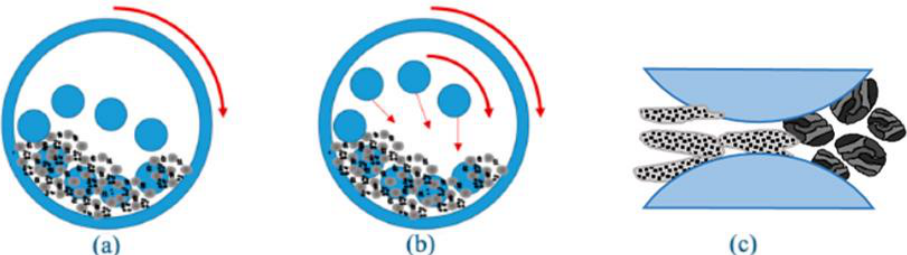
Figure 9. A schematic of the producibility of LHHSBM-Al powder; ( a ) stage 1, ( b ) stage 2, and ( c ) stage 3.